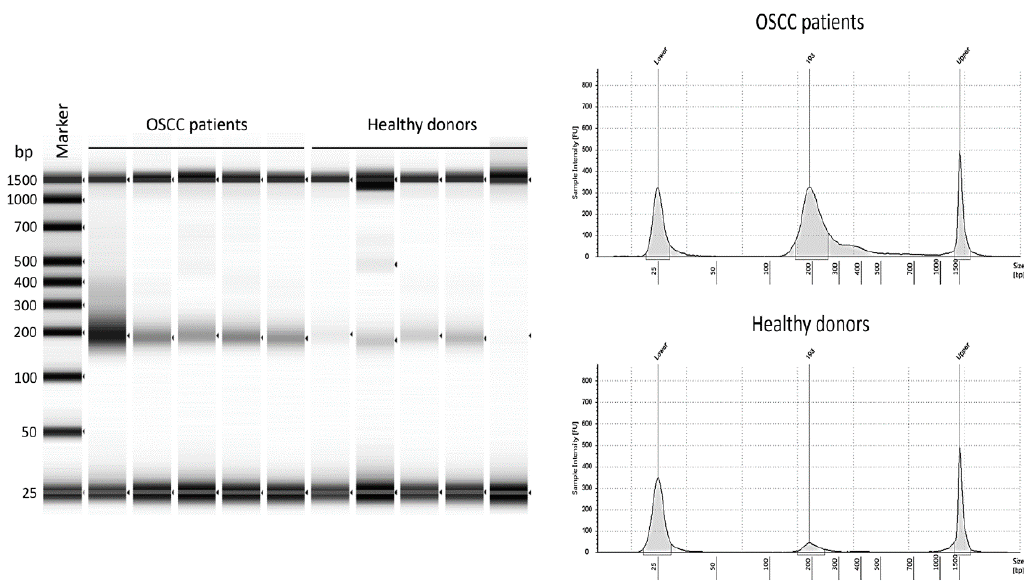
Figure 1. Agilent TapeStation analysis for the DNA integrity of oral squamous cell carcinoma (OSCC) samples and healthy donors.